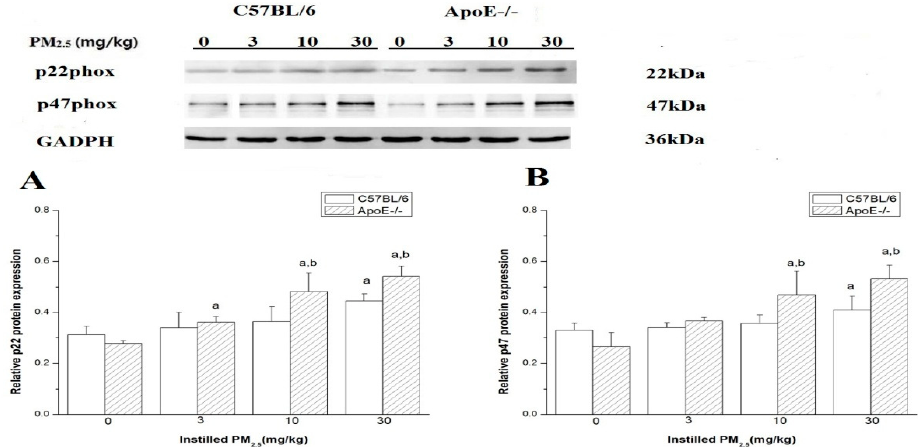
Figure 6. Protein expression of p22phox and p47phox in mice myocardium exposed to PM 2.5 by Western blot. ( A ) represents the relative p22phox protein expression in mice; ( B ) represents the relative p47phox protein expression in mice. The doses were 0 (control), 3, 10, and 30 mg/kg b.w. Significant difference ( a p < 0.05) between PM 2.5 group and control group, and significant difference ( b p < 0.05 ) between C57BL6 and dose- matched ApoE − / − mice were observed.